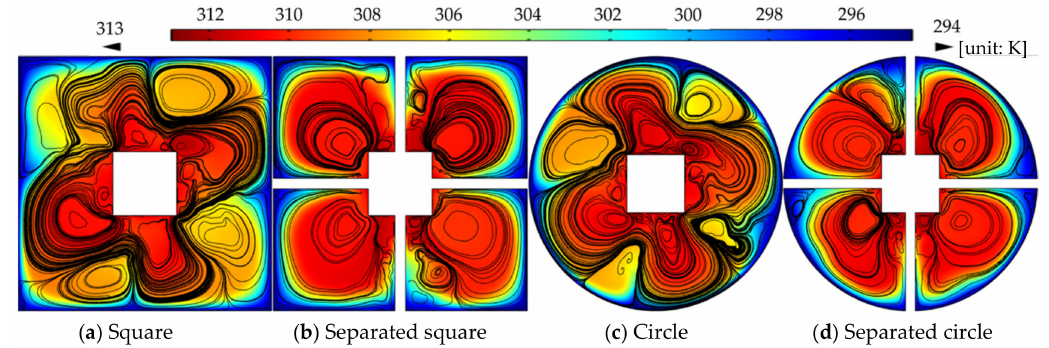
Figure 5. Streamlines and temperature distributions with the same magnetic field strength, H = 2000 (kA / m).